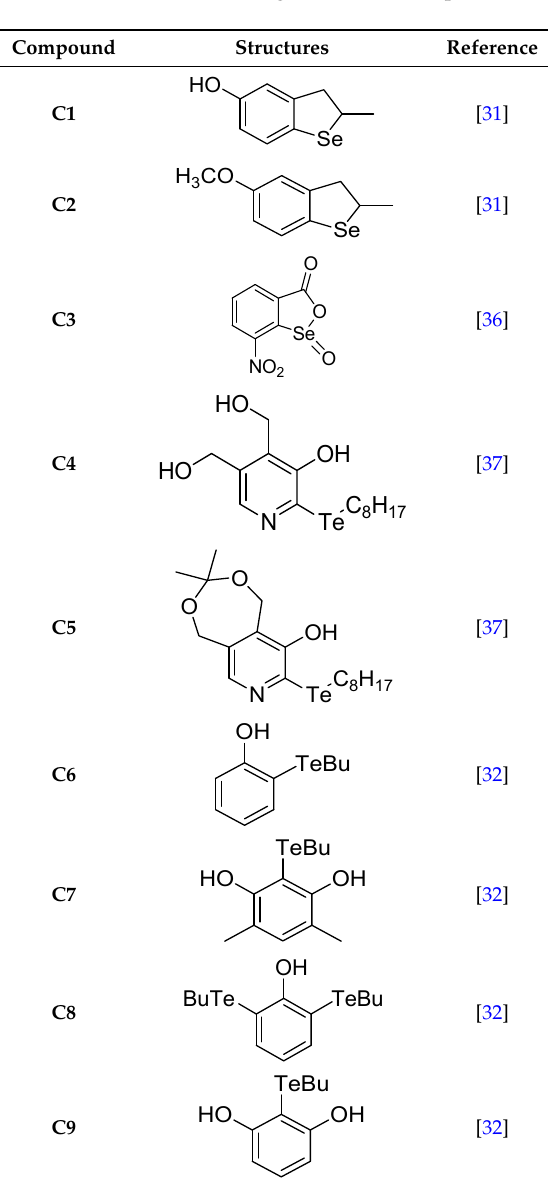
Table 1. Structure and origin of tested compounds.